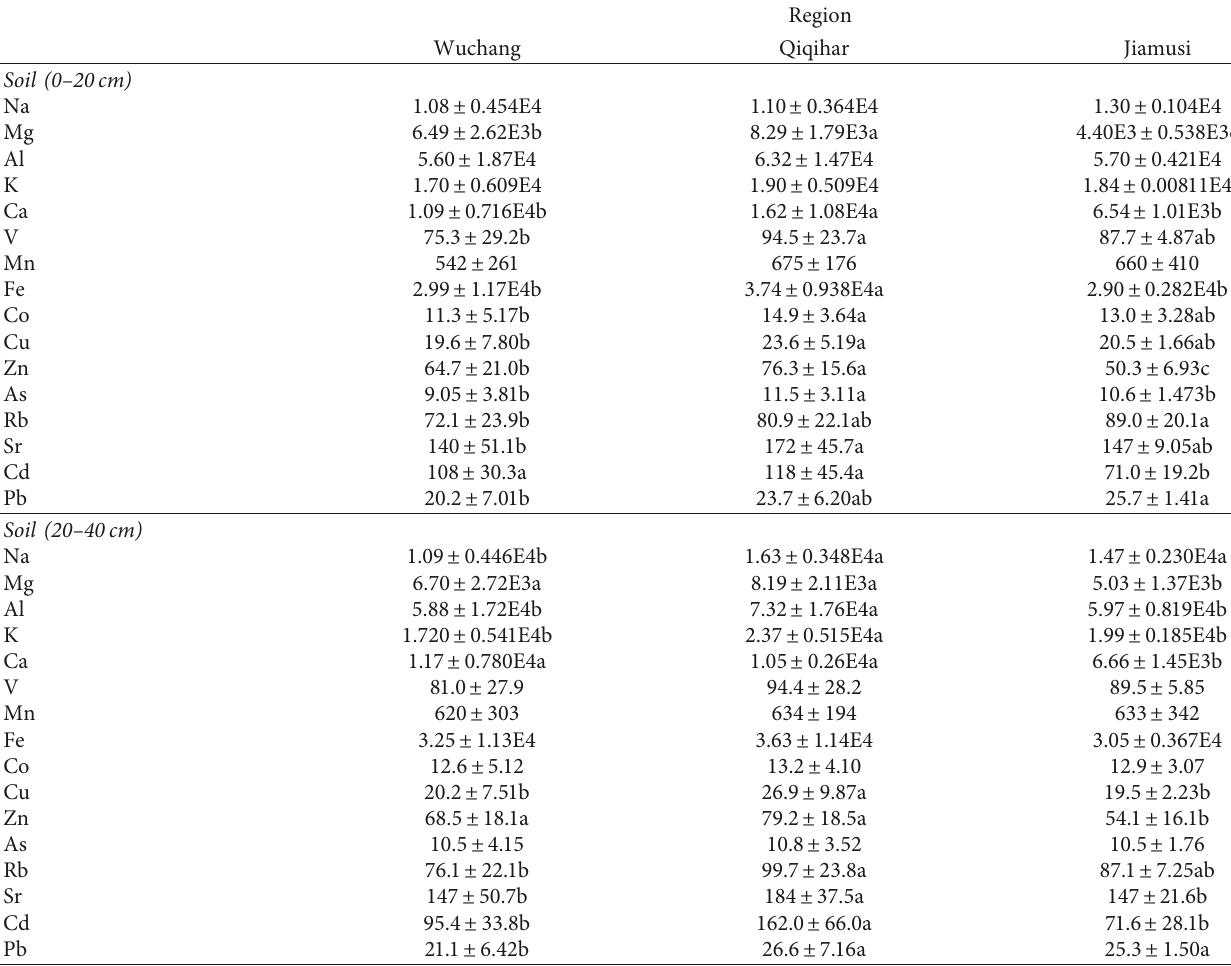
Table 4: Elements for soil samples (0–20cm and 20–40 cm) among three different regions ( µ g · g − 1 ).